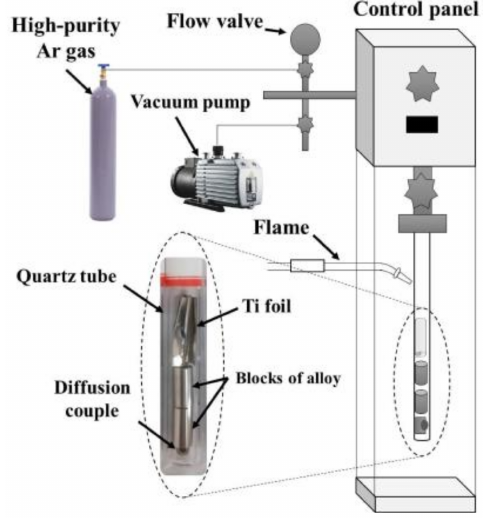
Figure 2. Experimental setup for the vacuum sealing process.